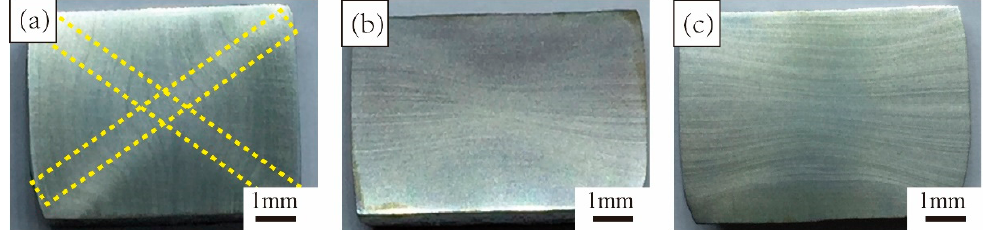
Figure 2. Microstructure of TC4 alloy after one cycle of MDIF: ( a ) one pass; ( b ) two passes; ( c ) three passes.